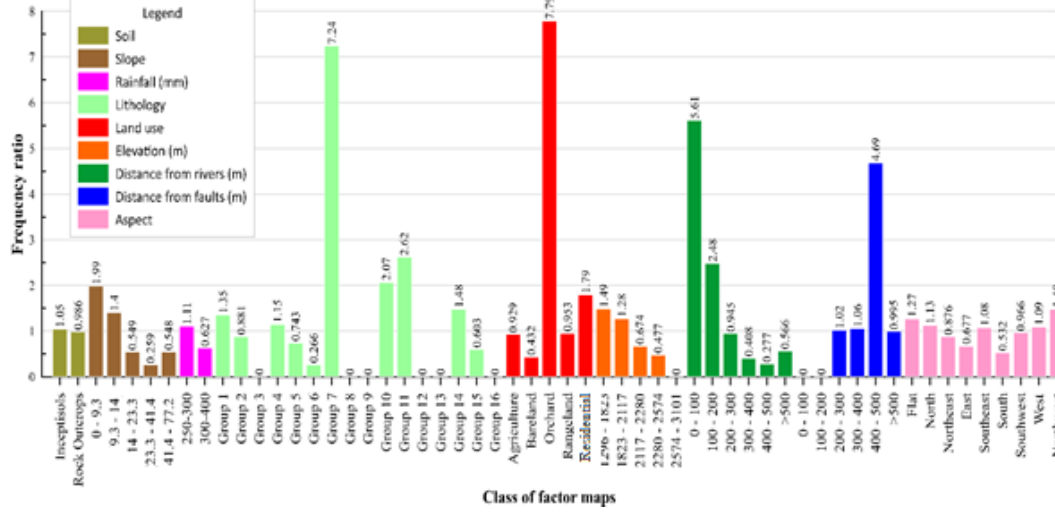
Figure 5. Frequency analysis of flash flood occurrence on the factor maps .